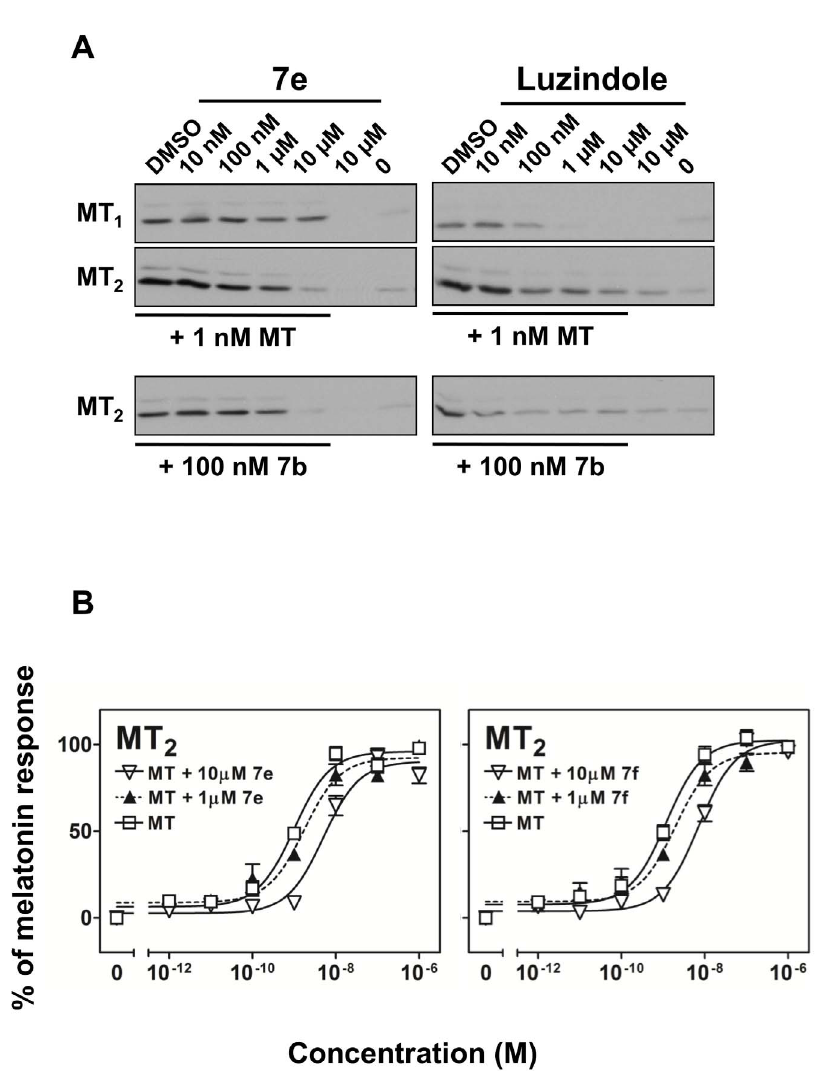
Figure 7. Blockade of ERK phosphorylation and Ca 2 + mobilization by an isoquinolinone-based melatoninergic antagonist. (A) CHO cells expressing MT 1 or MT 2 were treated with the indicated concentrations of 7e or luzindole in the absence or presence of a fixed concentration of melatonin (MLT) (for both MT 1 or MT 2 ) or 7b (for MT 2 only). Other experimental details were as to the legend of Figure 5. Data shown were representative blots of three separate trials. (B) CHO cells expressing MT 2 were treated with increasing concentrations (1 r M – 1 m M) of melatonin in the absence or presence of 10 m M or 1 m M of 7e or 7f . Other experimental details were as to the legend of Figure